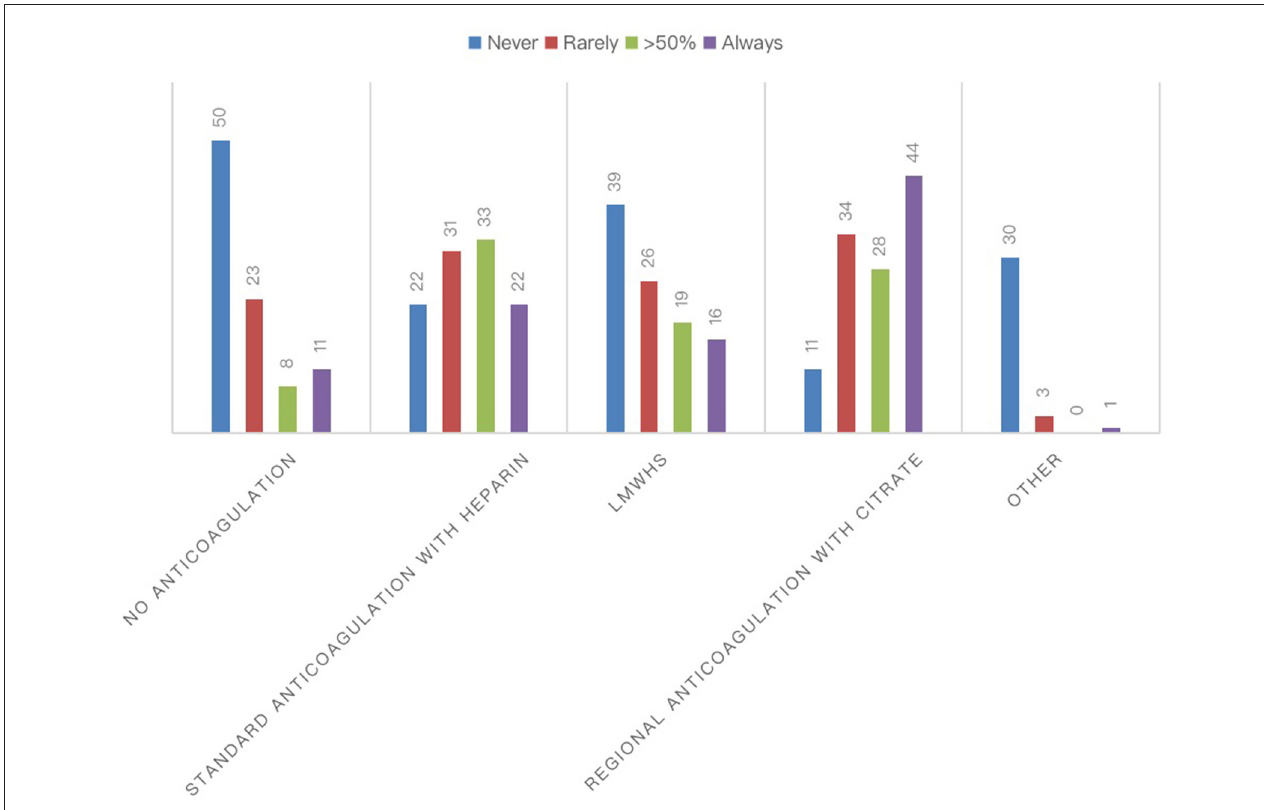
FIGURE 3 | Anticoagulation strategies for RRTs during COVID-19 pandemic. The chart showed the absolute number of different anticoagulation strategies for the extracorporeal circuit in patients with COVID-19.